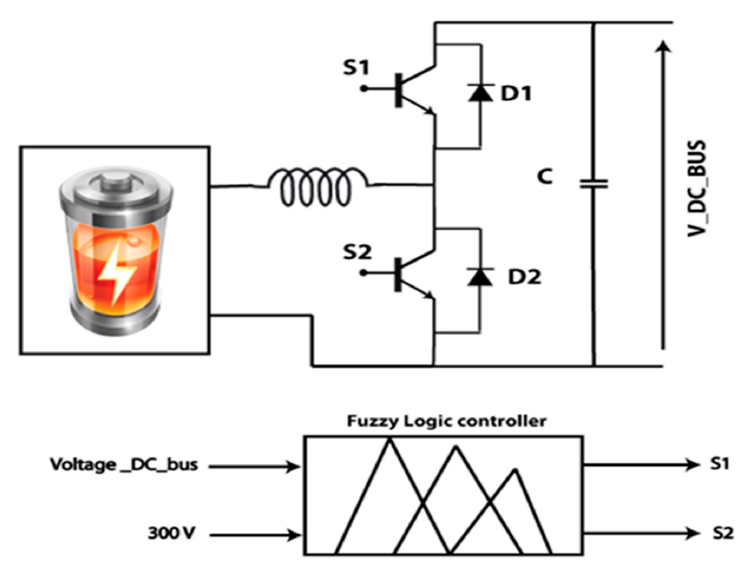
Figure 7. A battery storage system with a fuzzy logic controller .